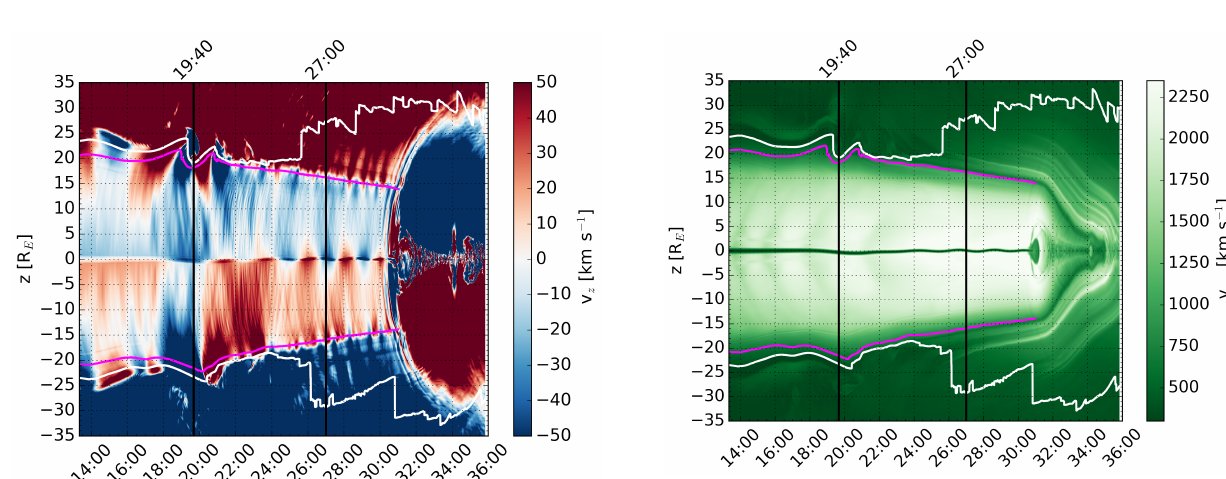
Figure 8. North component of the ion bulk velocity ( V z ) as a func- tion of z and time at y = 0 and x = − 40 R E . The vertical black lines are the same as in Fig. 2. The white and magenta (only plotted un- til 31:00) curves indicate the innermost boundaries where β ⊥ > 1 and β ⊥ > 0 . 1 in the region | z | > 5 R E , respectively. The tail lobes are estimated to lie between the white curves and the magnetosonic wave resonance cavity between the magenta curves.